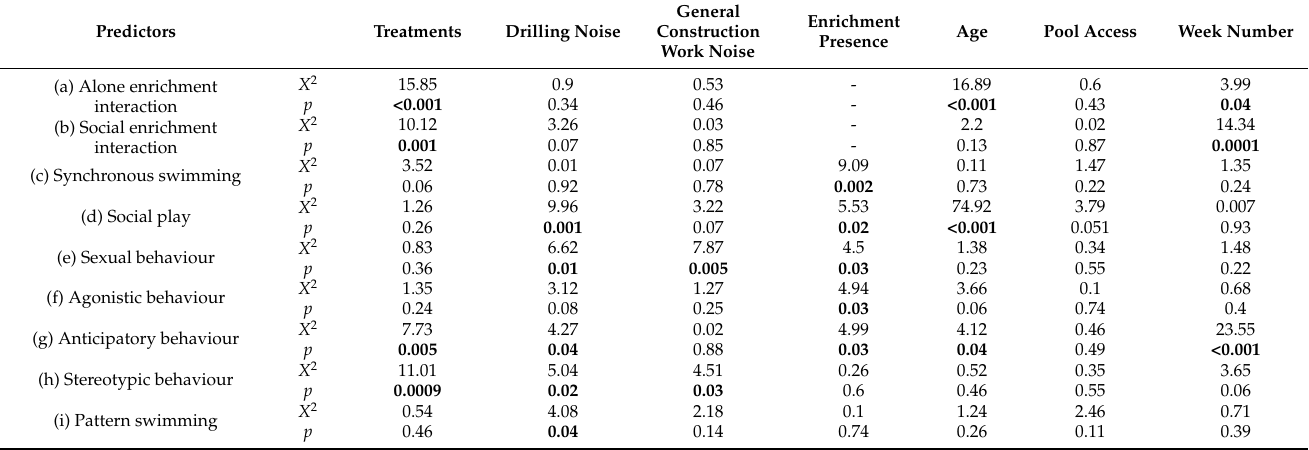
Table 5. Effects of treatments (non-cognitive vs. cognitive), week (week number of experiment), pool access (only show pool vs. both pools), age, enrichment (presence vs. absence, general construction noise (presence vs. absence) and drilling noise (presence vs. absence) on the occurrence of different behaviours of bottlenose dolphins. Multifactorial analyses by GLMM for proportional data (with a logit link) (c, d), by ZIGLMM for count data (h) and by a GLMM for count data with negative binomial distribution (a, b, e, f, i), all of these including dolphin identity as a random factor. Significant differences ( p < 0.05) are highlighted in bold. General Enrichment Treatments Drilling Noise Construction Presence Age Pool Access Week Work Noise